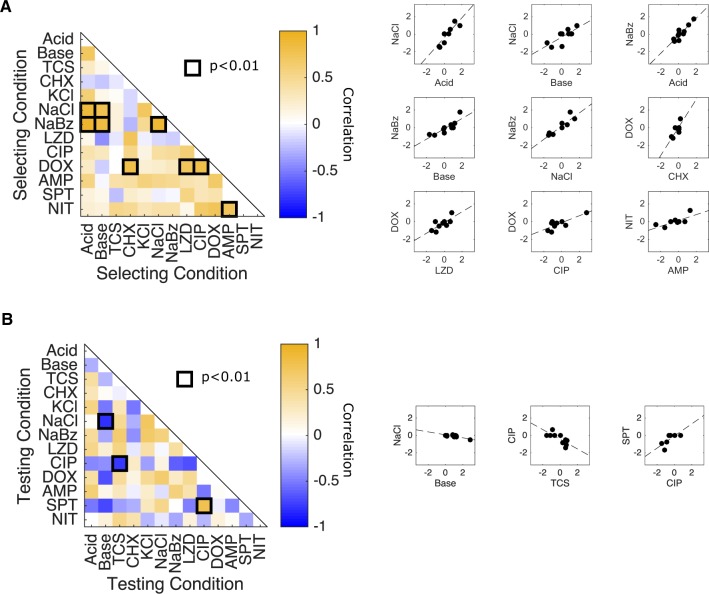
Correlations between collateral effects under different selecting or testing conditions. (A) Left panel: Pearson correlation coefficient between collateral profiles (i.e., columns of the matrix in fig. 1C) selected under different conditions. Dark squares highlight significant correlations (P < 0.01), which are also shown as scatter plots. Right panels: pairwise scatter plots of resistance profiles selected by different conditions (i.e., scatter plots comparing columns of the matrix in fig. 1C; only pairs with significant correlations, P < 0.01, are shown). Each point represents the measured resistance to a single stressor in isolates selected by the conditions on the horizontal and vertical axes, that is, each point is the resistance value c in each of the two conditions labeled by the axis. (B) Left panel: Pearson correlation coefficient between resistance levels to a particular testing condition (i.e., rows of the matrix in fig. 1C) across the ensemble of isolates. Dark squares highlight significant correlations (P < 0.01). Right panels: pairwise scatter plots of resistance levels to different conditions (i.e., scatter plots comparing rows of the matrix in fig. 1C; only pairs with significant correlations, P < 0.01, are shown). Each point represents a single isolate and shows the resistance of that isolate to the pairs of testing conditions on the horizontal and vertical axes. Put another way, each point represents the value c to each condition on the axis. To remove the effects of direct selection, which are typically larger in magnitude and may bias the correlations, the diagonal entries of the collateral sensitivity matrix (corresponding to resistance to the selecting condition) are removed prior to calculating all correlations. In all cases, resistance is measured in units of (log2-scaled) fold change in IC50 relative to ancestral strain (see supplementary figs. S1 and S2, Supplementary Material online, for scatter plots for all pairs).